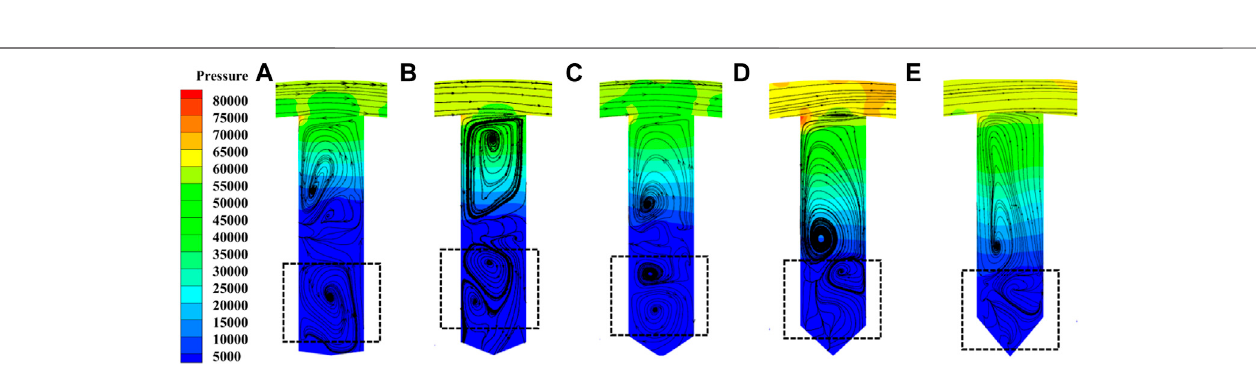
FIGURE 11 | Streamline distribution in hole: (A) L 1 = 1 mm, (B) L 2 = 3 mm, (C) L 3 = 5 mm, (D) L 4 = 7 mm, and (E) L 5 = 9 mm.